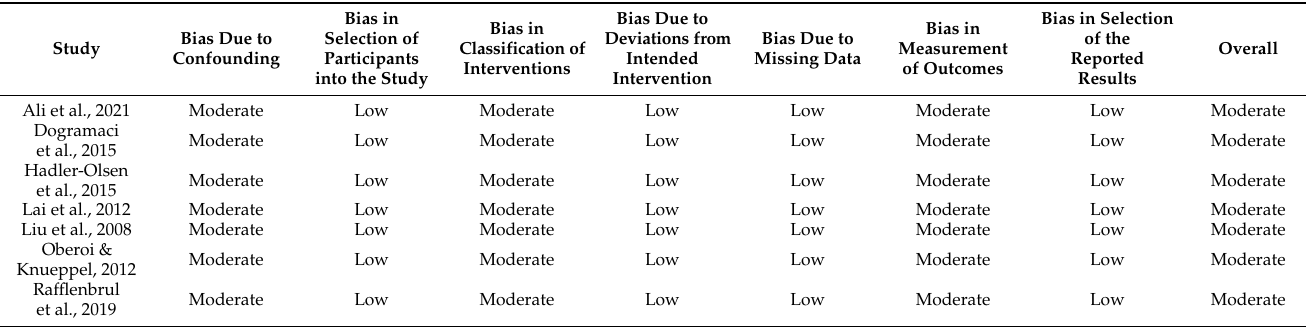
Table 2. Risk of bias in individual studies with ROBINS-I assessment tool